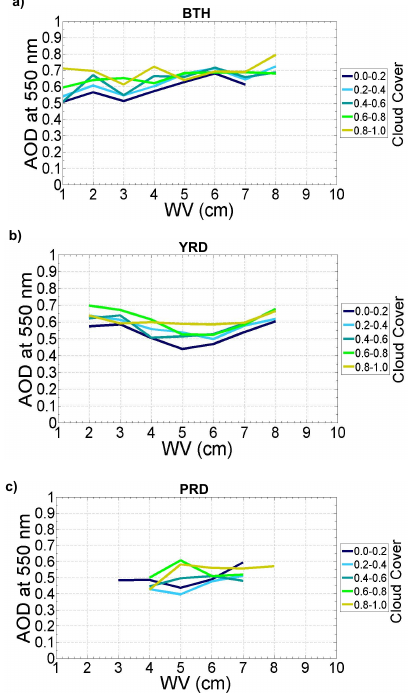
Figure 6. MODIS AQUA, AOD-WV-CC for SLP<1008 hPa over (a) Beijing–Tianjin–Hebei (BTH) urban cluster, (b) Yangtze River Delta urban cluster (YRD), and (c) Pearl River Delta (PRD), 2003– 2013. The AOD–WV line graphs were calculated by averaging AOD and WV within 1cm WV bins for several 0.2 CC